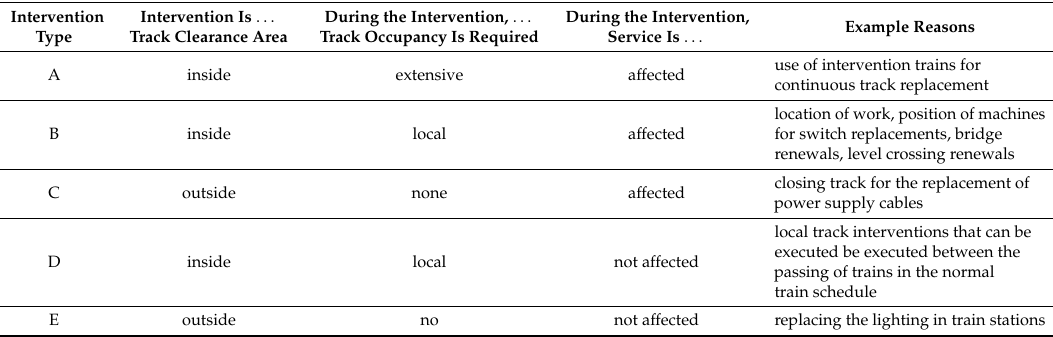
Table 1. Intervention types.